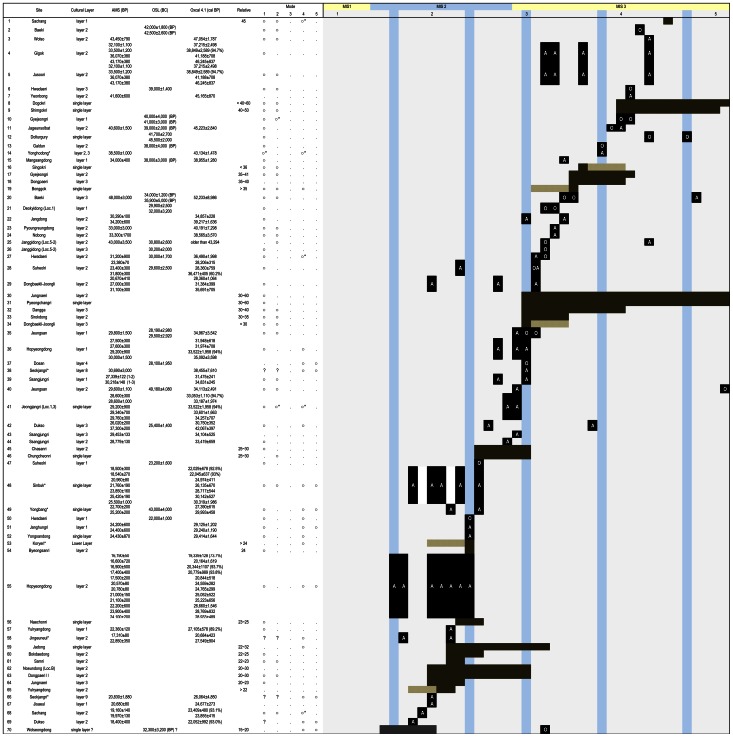
Selected Paleolithic sites in Korea.Representation of selected excavated Paleolithic sites yielding absolute and relative dates (from about less than 45 kya to more than 20 kya) in Korea. 1: [47], 2: [76], [77], 3: [78], 4: [79], 5: [80], 6: [8], 7: [77], 8: [81], 9: [82], 10: [83], 11: [84], 12: [76], 13: [77], 14: [85], 15: [77], 16: [77], 17: [83], 18: [86], 19: [87], 20: [77], 21: [88], 22: [20], 23: [77], 24: [89], 25: [90], 26: [90], 27: [8], 28: [73], 29: [72], 30: [48], 31: [91], 32: [48], 33: [92], 34: [1], 35: [44], 36: [7], 37: [48], 38: [2], 39: [15], 40: [44], 41: [6], 42: [93], [94] 43: [15], 44: [15], 45: [95], 46: [95], 47: [73], 48: [48], 49: [96], 50: [8], 51: [97], 52: [98], 53: [99], 54: [1], 55: [7], 56: [100], 57: [101], 58: [48], 59: [20], 60: [102], 61: [74], 62: [103], 63: [86], 64: [48], 65: [101], 66: [2], 67: [104], 68: [47], 69: [93], [94], 70: [105]. Note: The AMS dates quoted from primary references which are non-calibrated dates, while calibrating AMS dates obtained by OxCal 4.1.7 based on IntCal09 curve [22]. If not specified, the data are calculated at 95.4% probability levels. If not specified, AMS dates are addressed as B.P., while OSL dates are written as B.C. “*” on the mode sections is controversial for defining the technological mode due to typological classification, quantity or quality of data. On the graph, the figures inside the brackets represent calibrated AMS (A) and OSL (O). The sections horizontally shaded represent chronological data obtained by relative dating, where darker means more likely. The sections vertically shaded represent circa period of time for the Heinrich Events [106]. The Clark’s technological modes [17] are applied to determine the range of lithic technological variability [10] not for emphasizing distinctive and uppermost type fossils under the linear evolutionary scheme, thus the indicated modes can be plural in some cases.